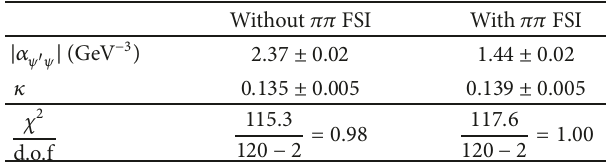
Table 1: The parameter results from the fits of the 𝜓 耠 󳨀→ 𝜓𝜋𝜋 processes with and without the 𝜋𝜋